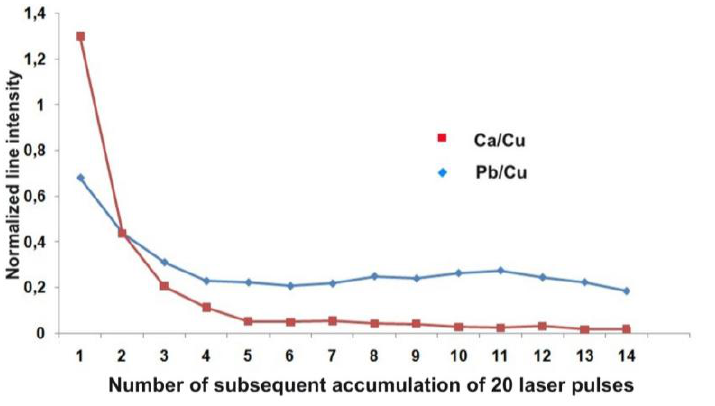
Figure 31. LIBS stratigraphy of Ca and Pb concentration in the